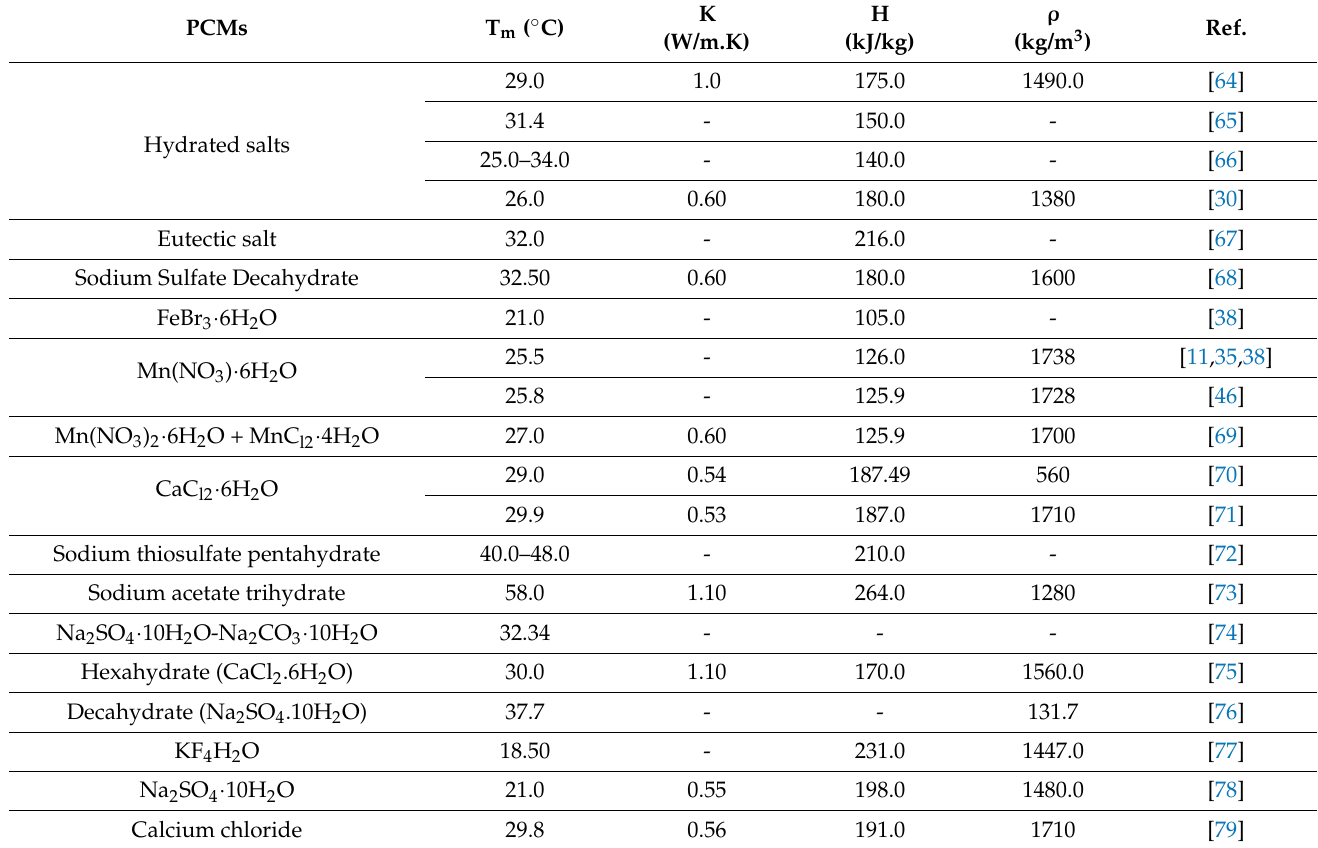
Table 4. Thermo-physical properties of different hydrated